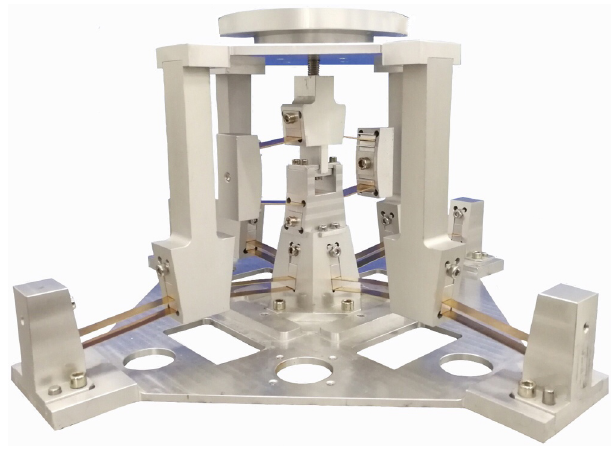
Figure 17. Force–displacement curve of the fabricated prototype platform.